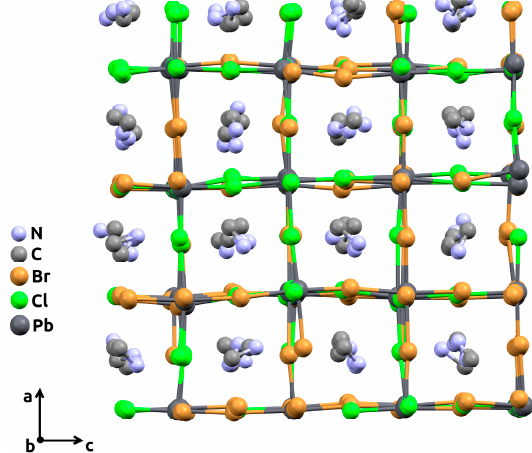
Figure 2. The 4 × 4 × 4 supercell (view along the crystallographic b- axis) with mi x ed chlorine- bromine content ( x = 0.5), obtained after molecular dynamics simulation procedure. Hydrogen atoms are omitted for clarity.